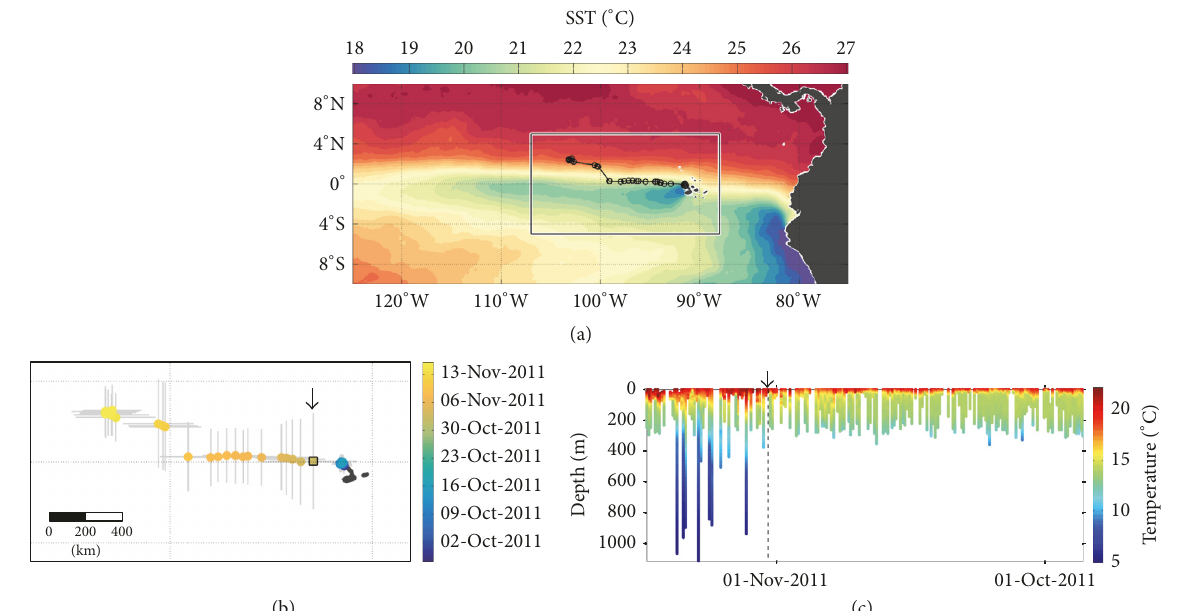
Figure 4: Spatial occupancy and diving behavior of MR1 (tag 110731). (a) Average sea surface temperature (SST) during the tracking period, with the track overlaid in black. (b) Track timing (color) and 95% confidence interval of positions (gray lines) are represented for the inset region of (a). The black square identifies the start of the westward migration along the equatorial upwelling front. (c) Temperature profiles along the track; time progresses from right to left for consistency with (b), and the vertical dashed line marks the time of the position marked by the black square in (b).